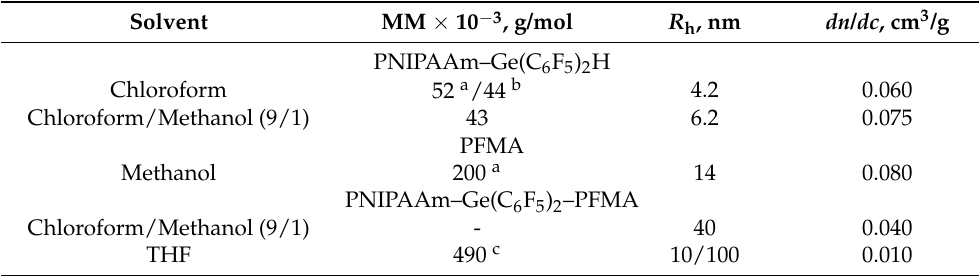
Table 1. Molar masses and hydrodynamic characteristics for functional polymer